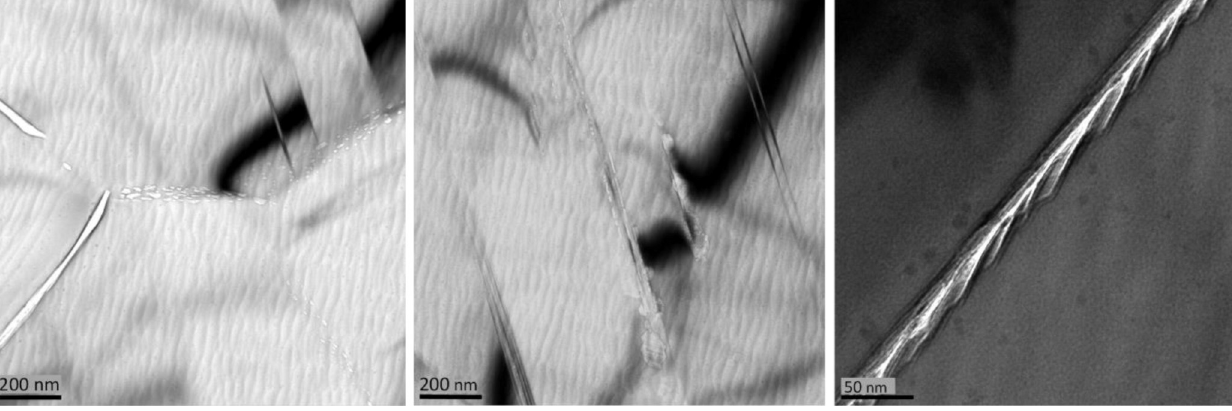
Fig. 13. 4 He implanted in B 4 C and annealed at 1500 ° C. Left: two triple points. Helium was trapped in the grain boundaries in the form of bubbles, or the grain boundaries are opened. Middle: helium bubbles located at twin boundaries (riddles due to FIB thinning). Right: opened grain boundaries with a shape of “ stair steps ”